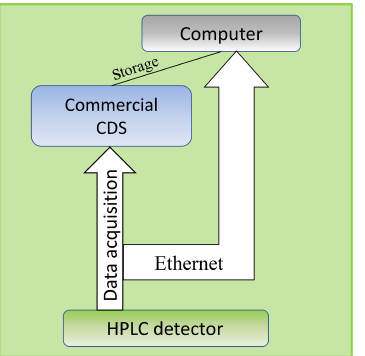
Figure 1. The whole configuration using the Second Controller In- stance for a parallel data acquisition. It runs concurrently with the commercial chromatography data system (CDS) which parameter- izes the HPLC system and starts/stops all experiment sequences.